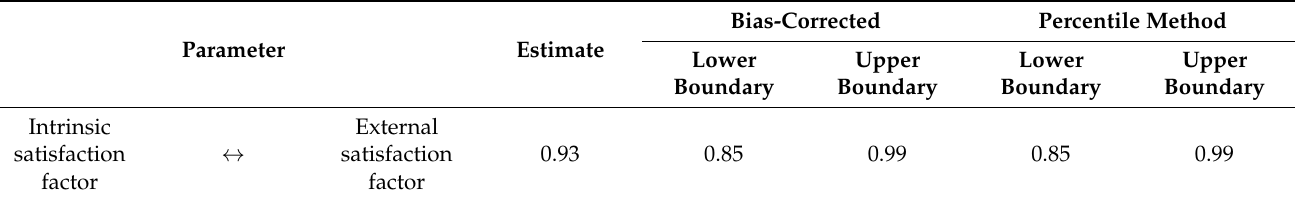
Table 6. Job satisfaction—bootstrap 95% confidence interval table of related coefficients.